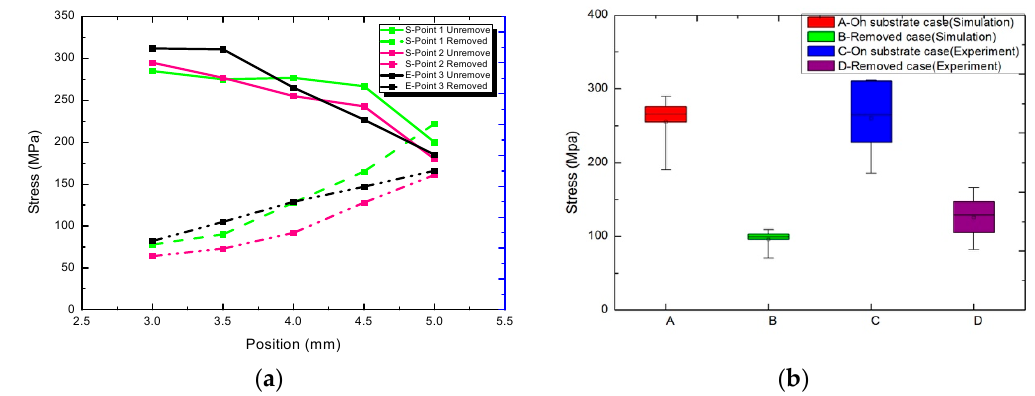
Figure 10. Residual stress value before and after removal of the substrate: ( a ) curve; ( b ) boxplot.